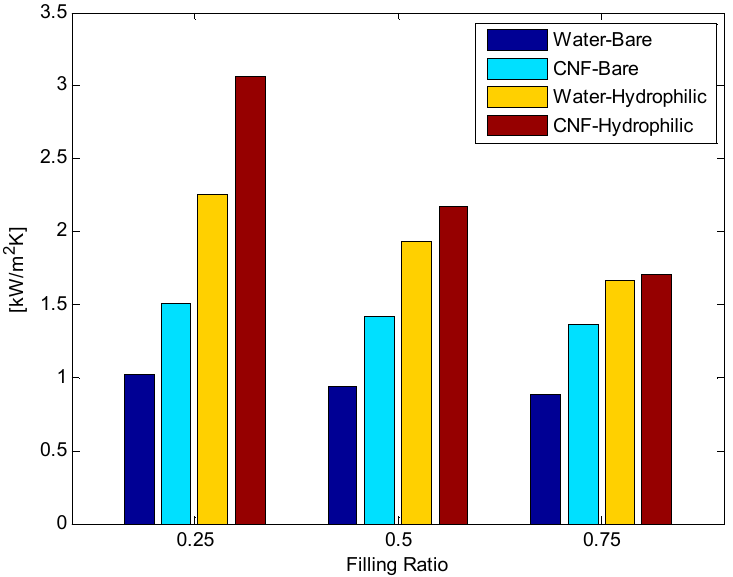
Figure 13. Comparison of boiling heat transfer